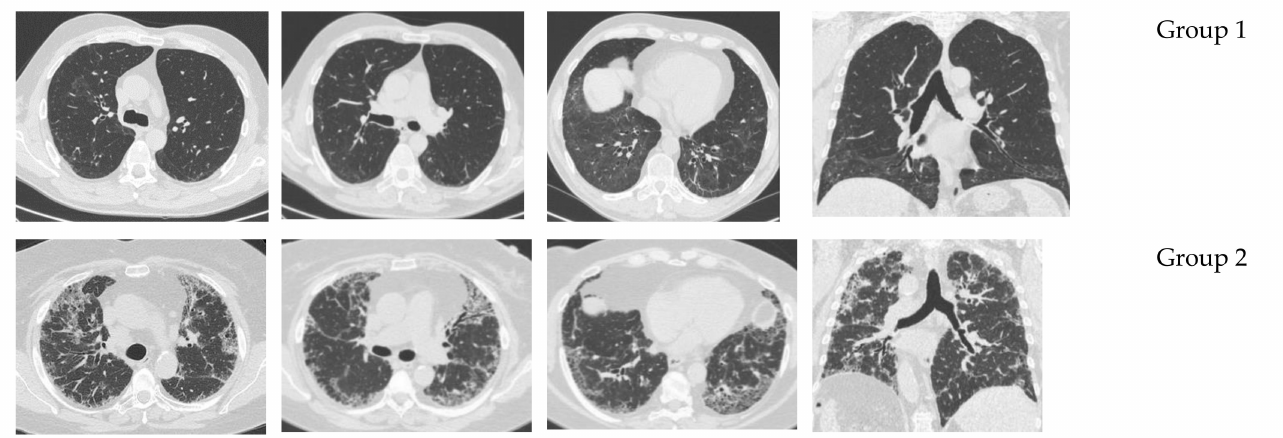
Figure 1. Representative CT scan imaging demonstrating the fibrotic lung involvement in patients belonging to Group 1 (representing patients in absence of true pathogen in broncho-alveolar lavage) or Group 2 (representing patients in the presence of pathogens in broncho-alveolar lavage). Note the different fibrotic involvement. Note the ground glass and reticular opacities. Moreover, a relationship between traction bronchiectasis and bacterial colonization was not